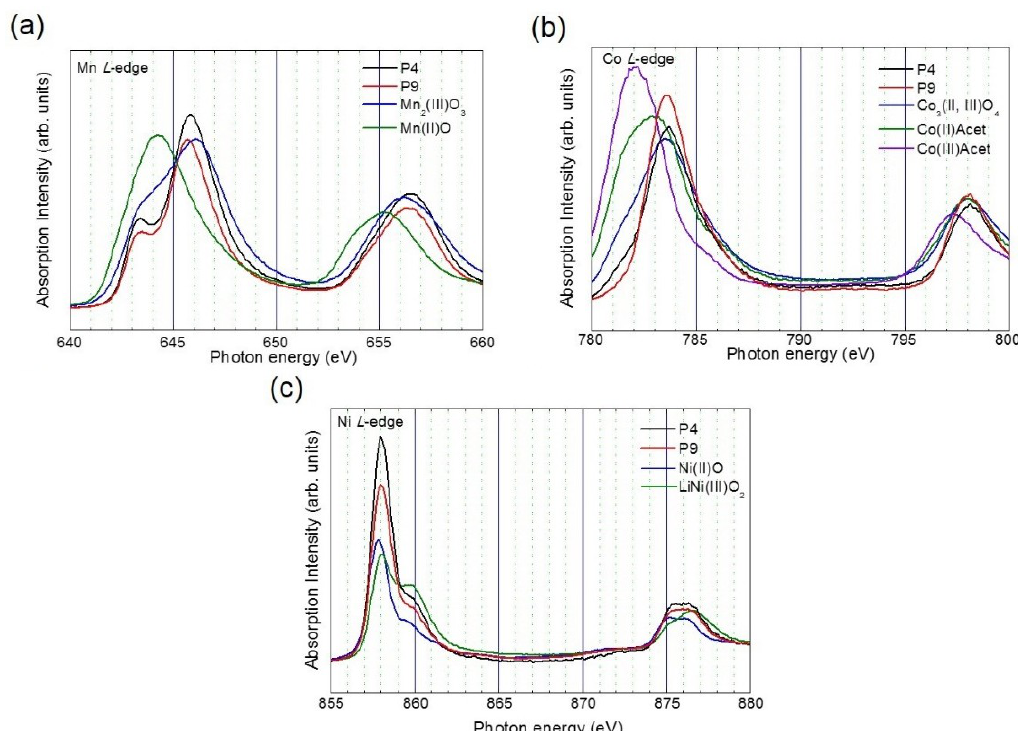
Figure 7. ( a ) Mn, ( b ) Co, and ( c ) Ni L -edge XANES spectra of thin films deposited at positions P4 and P9.